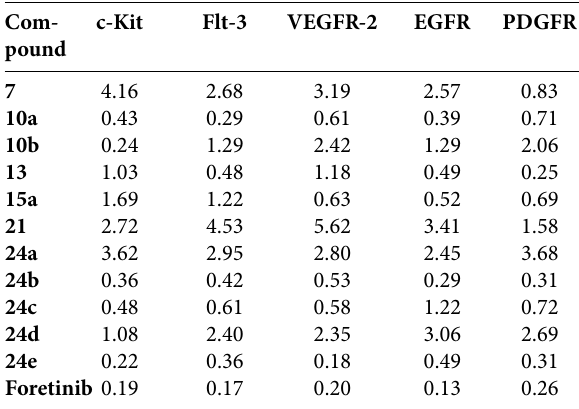
Table 3 . Inhibition of tyrosine kinases (Enzyme IC 50 (nM) by com- pounds 7, 10a, 10b, 13, 15a, 21, 24a, 24b, 24c, 24d and 24e